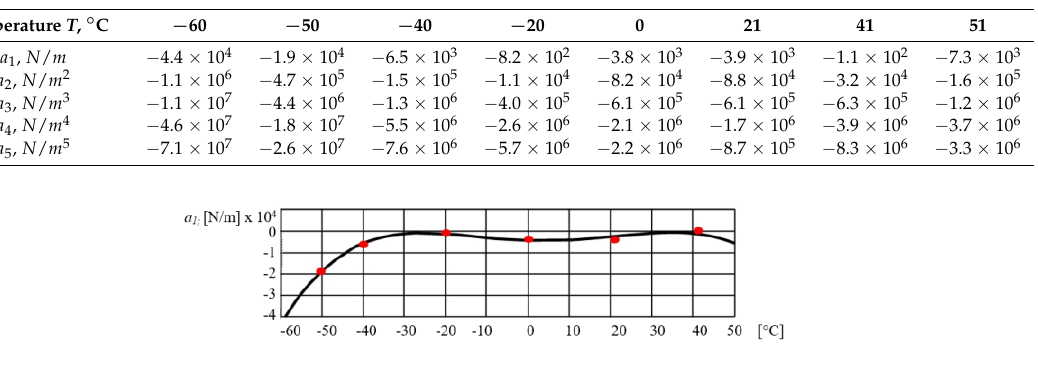
Table 1. Polynomial coefficients for different temperatures.